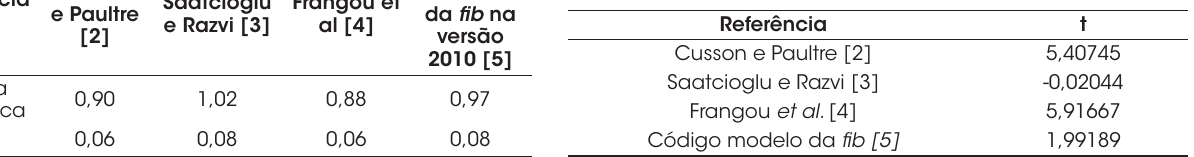
Aplicação do teste t-Student nos pilares confinados com armadura transversal – t crítico =